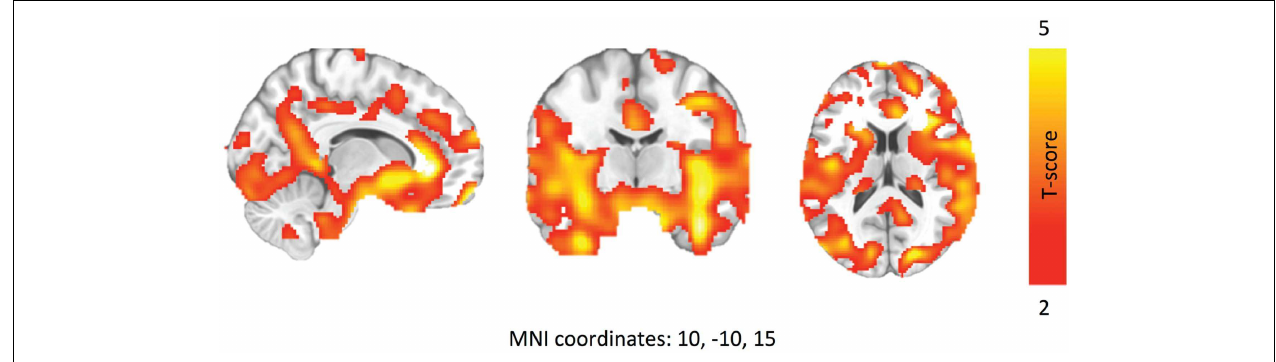
FIGURE 2 | Brain regions where patients with MS have lower FDG uptake after walking challenge .Walking speed has been modeled out as a nuisance factor. Data are thresholded at P < 0.01, FDR